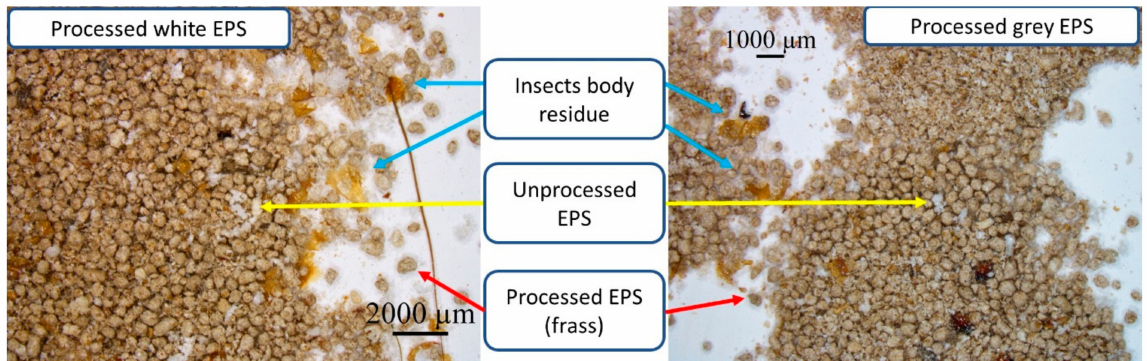
Figure 7. Microscopic images of frass obtained after the consumption of white and grey EPS by Tenebrio molitor